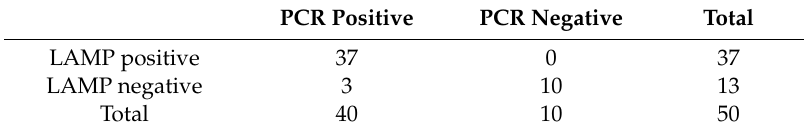
Table 3. Contingency table for the comparison of LAMP and PCR in the detection of E. canis